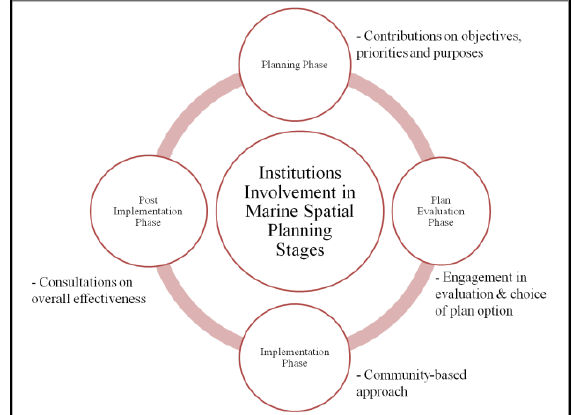
Figure 3. Institutions Involvement in Marine Spatial Planning Stages (Modified after Gopnik et al., 2012 and Pomeroy and Douvere,